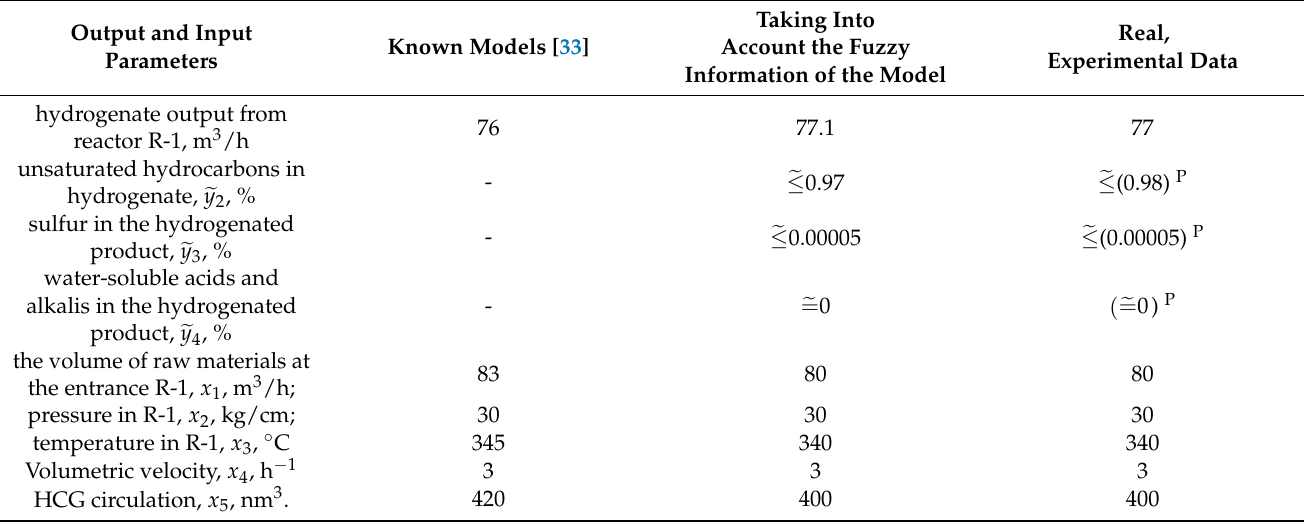
Table 3. Results of comparison of data obtained with known models, developed models and real, experimental data from the hydrotreating unit of the LG-35-11/300-95 unit of the Atyrau refinery.